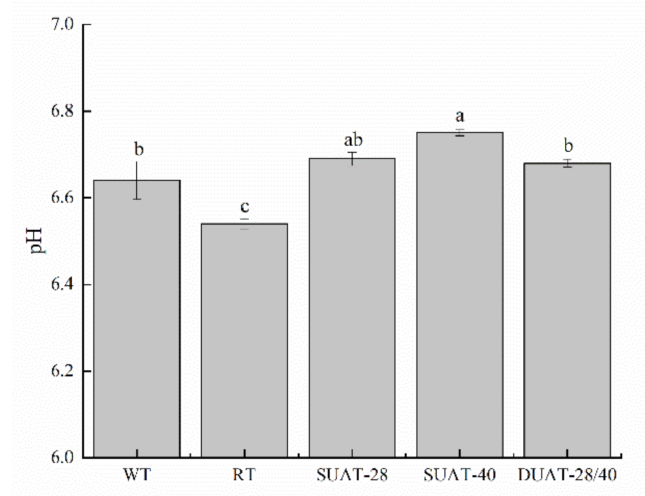
Figure 3. Differences in pH value of large yellow croaker under different thawing methods. (WT: water thawing; RT: refrigerated thawing; SUAT-28: single-frequency ultrasound-assisted thawing at 28 kHz; SUAT-40: single-frequency ultrasound-assisted thawing at 40 kHz; DUAT-28/40: dual- frequency ultrasound-assisted thawing at 28 kHz and 40 kHz). Different superscript letters indicate significant difference ( p < 0.05).